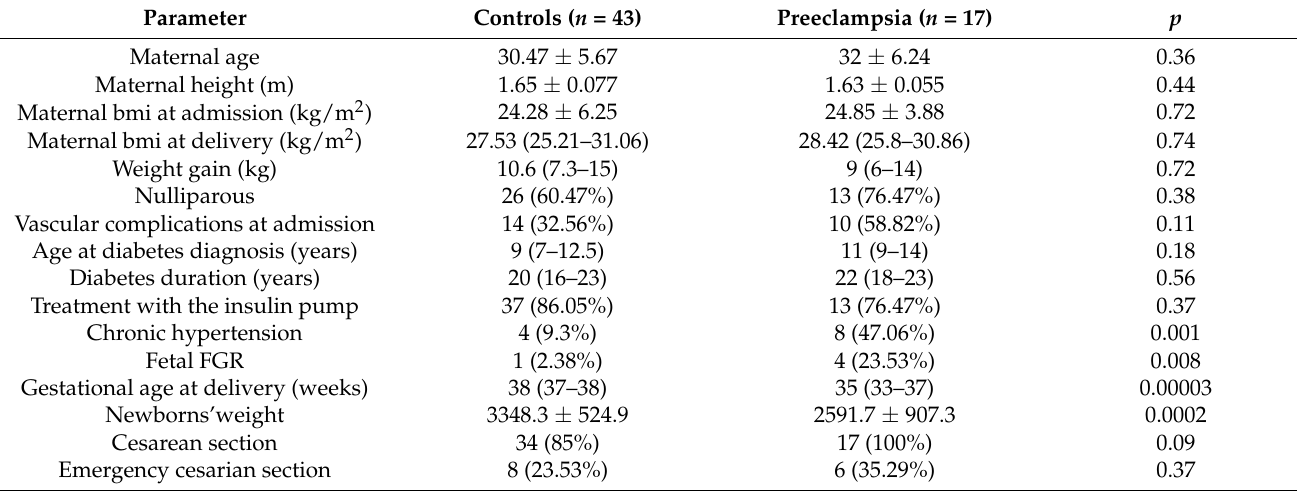
Table 1. Maternal characteristics in PE patients and the control